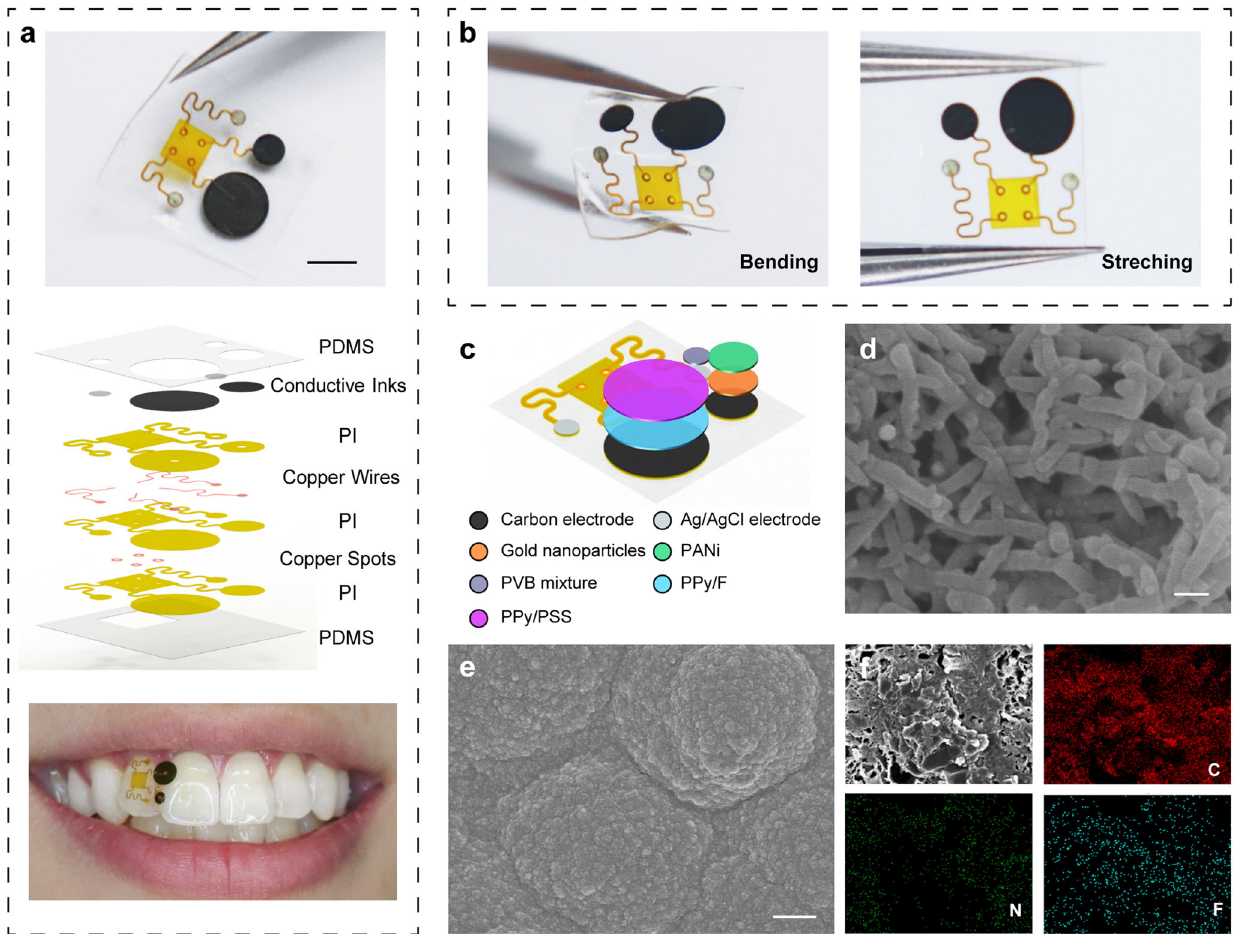
Fig. 2 Fabrication and characterization of the fl exible electrode array. a Optical image and the exploded view of the electrode array. Scale bar, 3 mm. The electrode array consisted of screen-printed conductive inks as the electrochemical electrode interface, copper wires and copper spots as the conductive tracks, and PI and PDMS fi lms as the substrates and encapsulations. The fl exible electrode array was miniaturized, ultrathin, and lightweight, which could conformally interface on the tooth. b Mechanical deformations of the fl exible electrode array including bending and stretching. c Schematic of multilayer modi fi cation of the electrodes in an exploded view. d Scanning electron microscope (SEM) image of polyaniline (PANi) modi fi ed electrode. Scale bar, 100 nm. e SEM image of polypyrrole (PPy) modi fi ed electrode. Scale bar, 1 μ m. f Energy dispersive spectroscopy (EDS) images of polypyrrole/ fl uoride (PPy/F) electrodeposited on the working electrode of the drug delivery module, including C (red), N (green), and F (blue) elemental